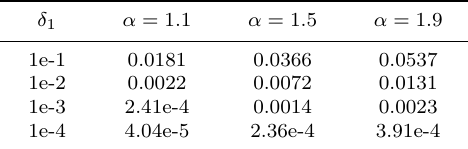
Table 1. E f for various α and δ